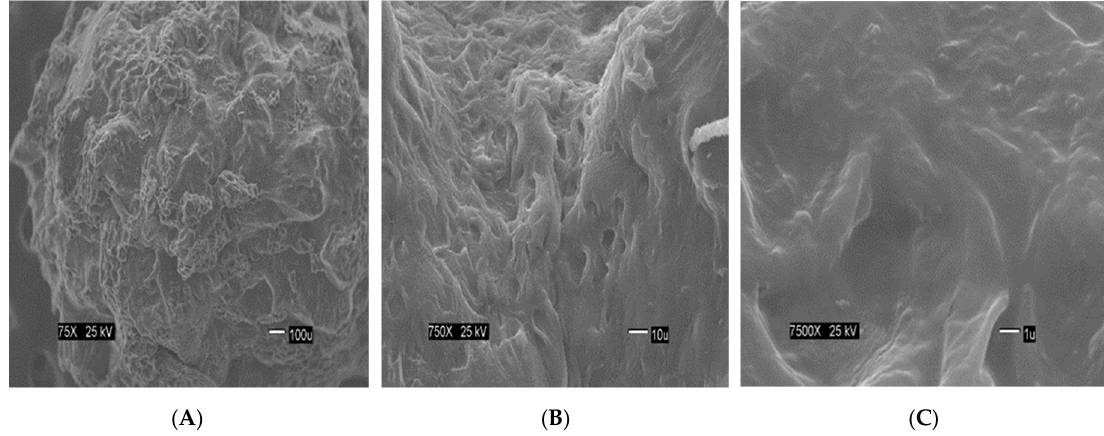
Figure 5. SEM images at three different magnitudes of CA-SCGs (3:10) beads: ( A ): 75×, ( B ): 750× and ( C ): 7500×.